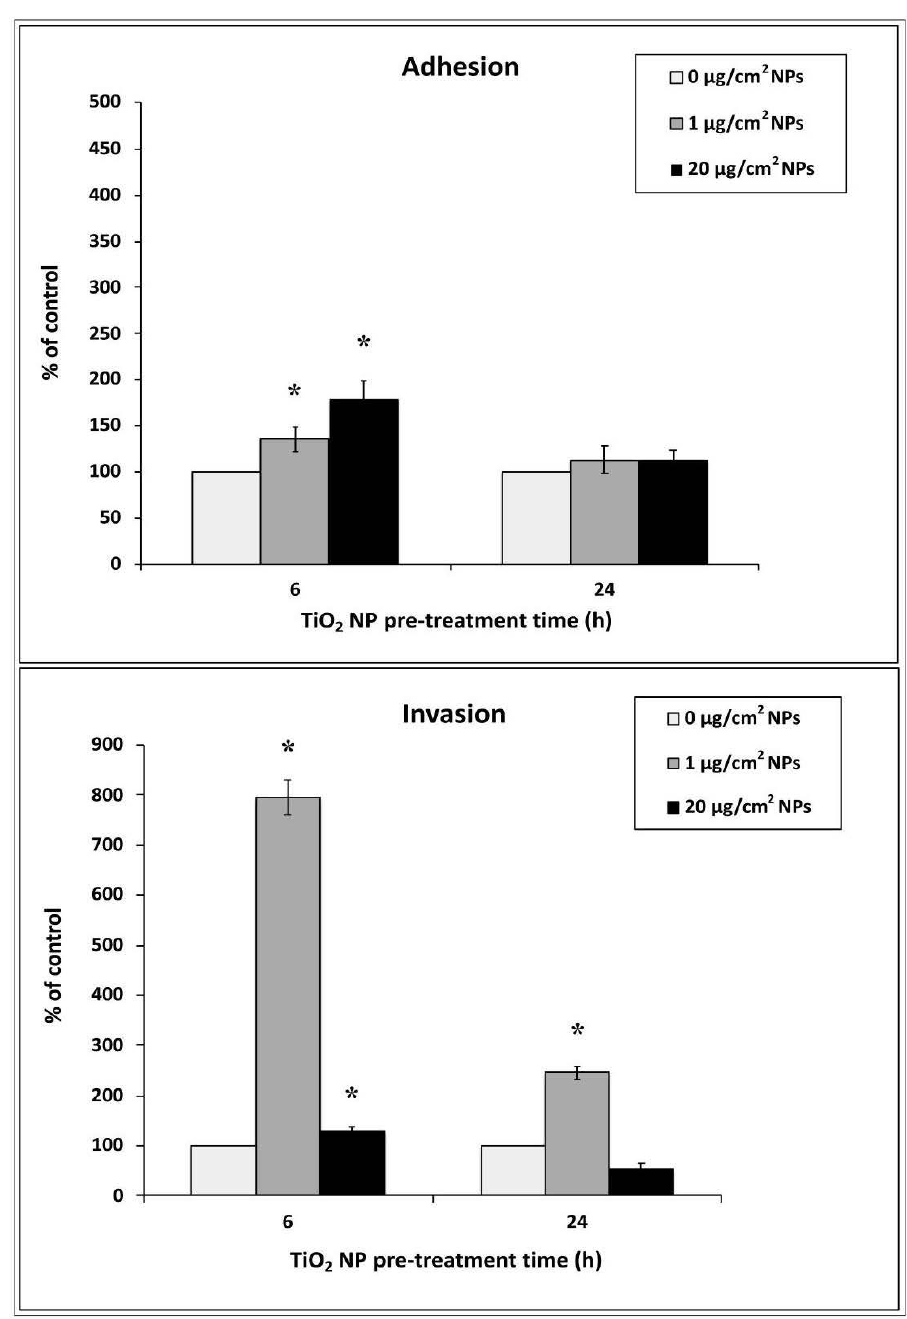
Figure 3. Adhesion and invasion efficiency of EGD-e strain in HT-29 cells pre-treated with TiO 2 NPs at either low or high doses. Values are expressed as a percentage of control untreated infected cells (taken as 100%) with means ± SD calculated from three independent experiments. Asterisks denote statistically significant values compared to control untreated infected cells (* p < 0.05).